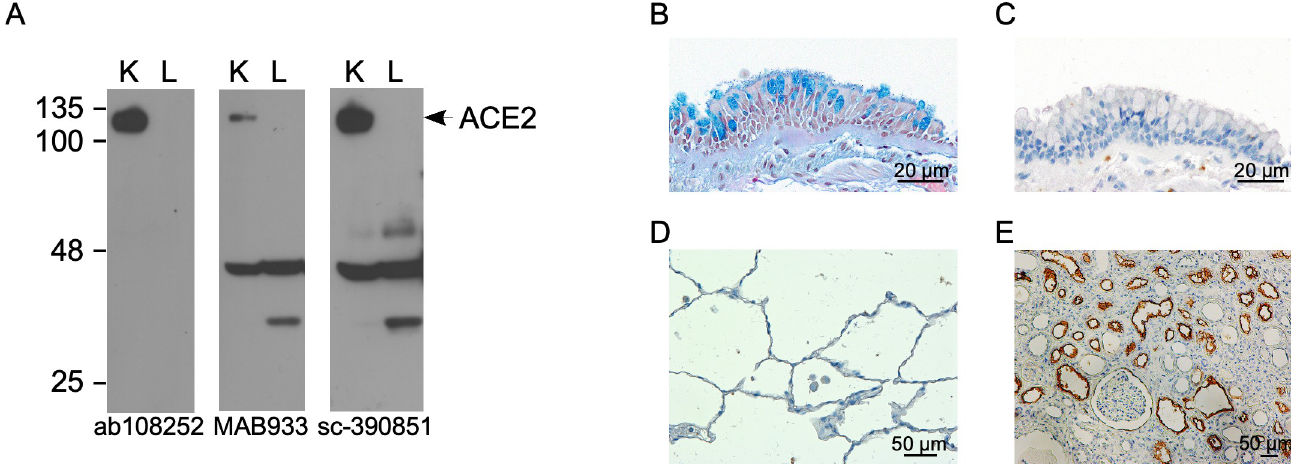
Fig 1. ACE2 expression is not detected at baseline and not induced by cigarette-smoke exposure or bronchopulmonary dysplasia in adult NHP lungs. Representative immunoblots with kidney and lung homogenates (30 mg/lane) from C . macaque model of cigarette-smoke-induced airway injury; identical membranes were probed with 3 different ACE2 antibodies as indicated on the image. K, kidney; L, lung (A). Representative image of lung section from C . macaque model of cigarette-smoke-induced airway injury stained with Alcian Blue (AB) and H&E demonstrating abundant goblet cells in the bronchial epithelium (B), but lack of ACE2 immunoreactivity in bronchial (C) and alveolar epithelial cells (D). A human kidney section was used as a positive control and demonstrates abundant ACE2 expression in proximal tubular epithelial cells (E).